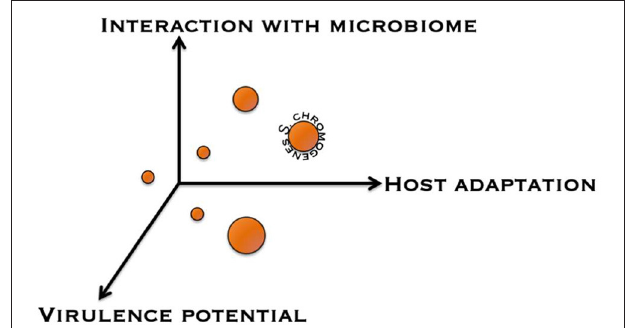
FIGURE 3 | Conceptual discrimination of different non- aureus staphylococci based on several factors. Displayed are the interaction with the udder microbiome, host adaptation, and virulence